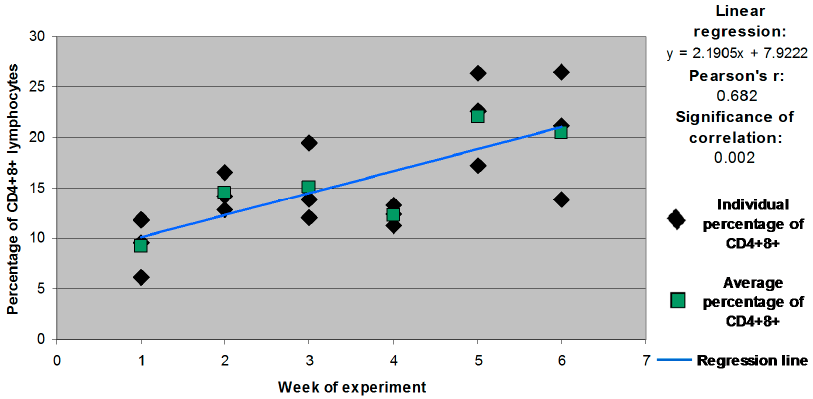
Figure 2. Individual and mean percentages of CD4 + 8 + lymphocyte subpopulations in group C.